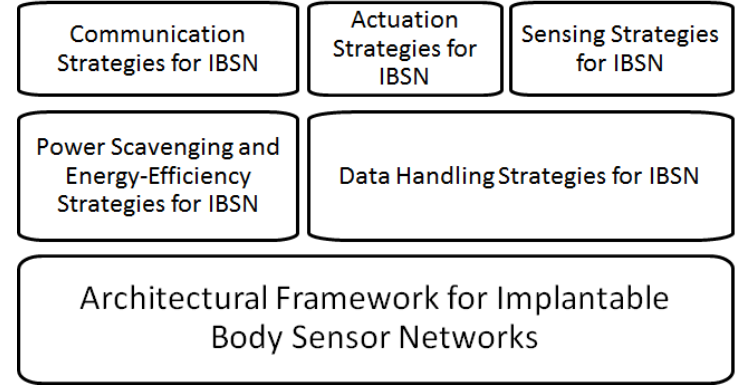
Figure 2. Common architecture of IBSN sensor nodes.